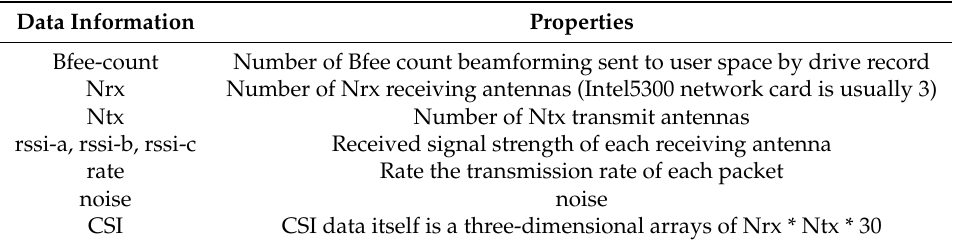
Table 2. Channel state